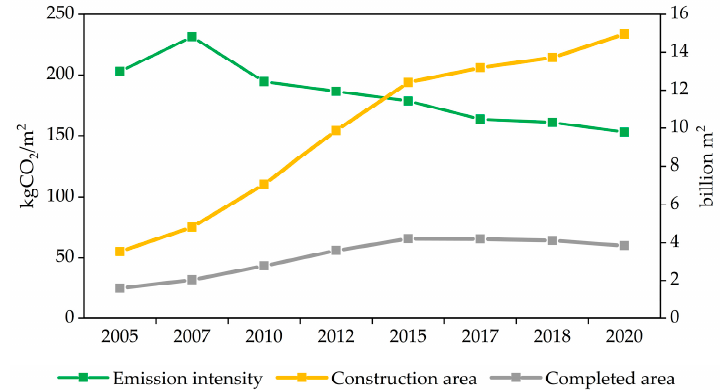
Figure 14. Building embodied emission intensity and construction scale (2005–2020).